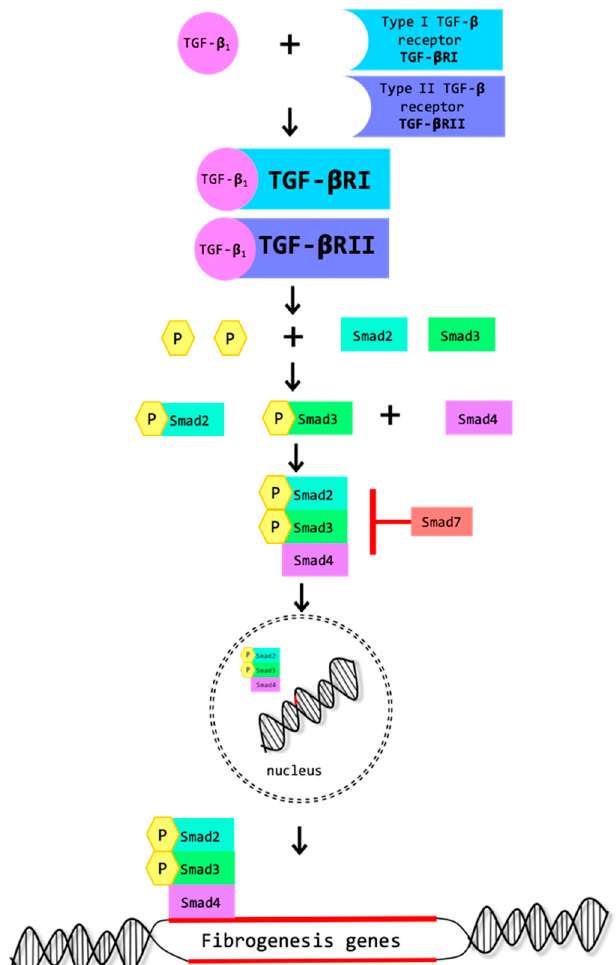
Figure 2. Smad-dependent onset of fibrosis. TGF- β 1 binds to TGF- β Receptors type I and II (TGF- β RI and TGF β -RII), involving Smad2 / 3, which must become phosphorylated in order to form a complex with Smad4. Smad7 has the capacity to repress the complex. The complex translocates to the nucleus, where it is required for the transcription of their target fibrogenesis genes.